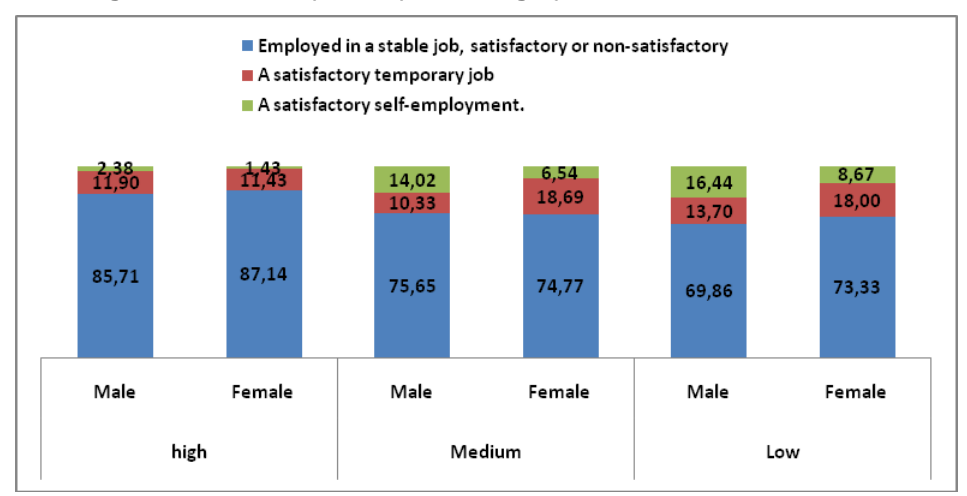
Figure 5: Transited youth by sub-category, sex and levels of education